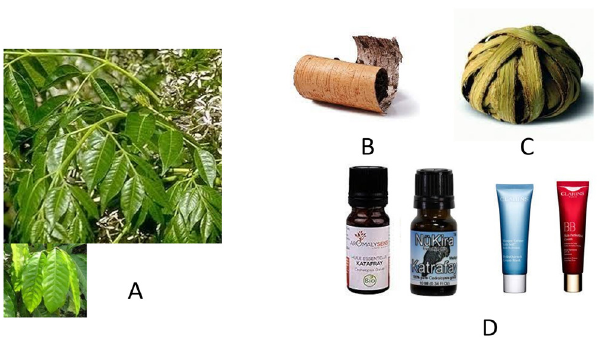
Figure 4. The plant and products of Cedrelopsis grevei . ( A ) The plant, with details of the leaves. ( B ) Rolled bark of the tree, often sold in this form. ( C ) Typical “boule de katrafay” available on local market and at Madagascan souvenir and handicraft shops. ( D ) Commercial preparations of essential oils and creams obtained from the bark of the tree. The essential oil is obtained by distillation of the bark of the plant. The wood is used to build the traditional houses, but also boats. The oil is used for massage, ambient deodorizing, and local body application. In any case, consumption as food is to be avoided. Katafray treatment is often associated with ylang ylang, another botanical fragrance common in Nosy Be, a large island on the Northern coast of Madagascar. However, ylang ylang, though commonly diffused in Madagascar, originates from Far East areas such as the Philippines, Myanmar and India.